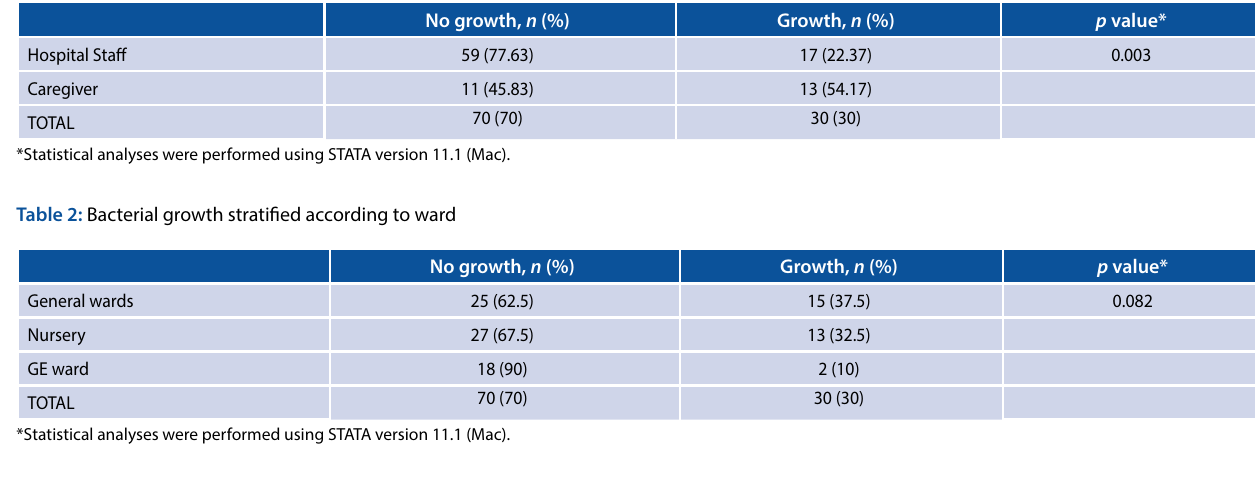
Table 1: Bacterial growth according to staff designation